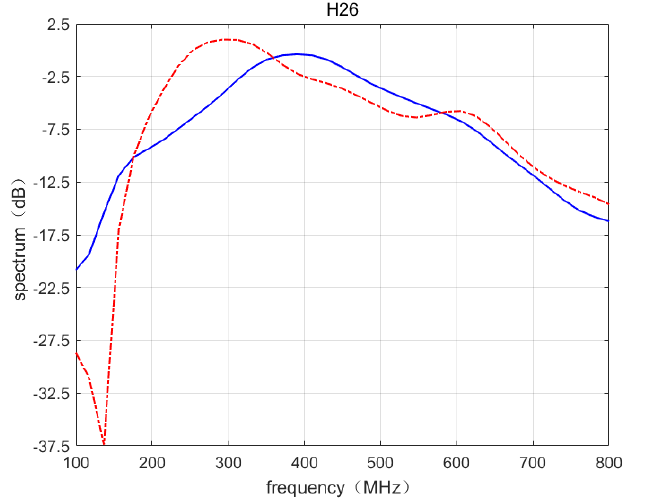
Figure 4. The spectrum components measured are plotted, and it can be observed that the bandwidths of the transmitted signal are wide.